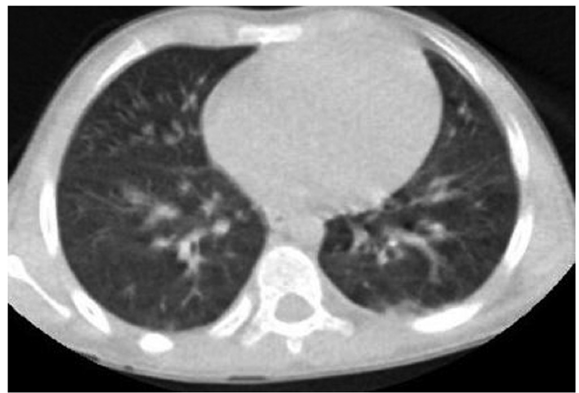
Figure 4. High-resolution computed tomography (HRCT) of a 9-year-old male patient with Kawasaki disease and COVID-19 pneumonia: Passive atelectatic changes on the right, ground-glass opacities near the pleural surface bilaterally and patchy ground-glass opacities in the middle lobe of the right lung. COVID-19: coronavirus disease